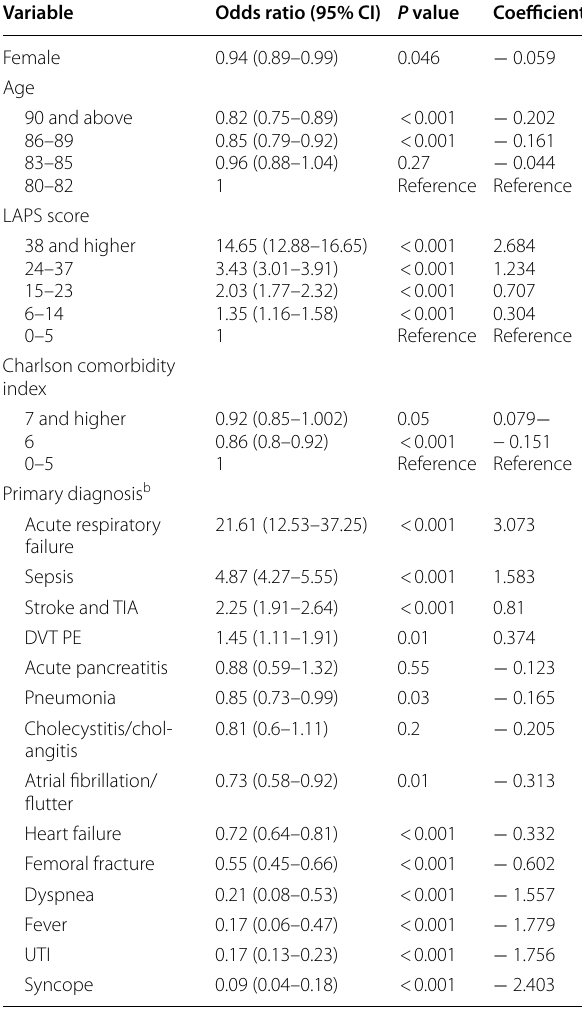
Figure 1 and Additional file 1: Table S5 show mortal- ity data of patients with the highest probability of ICU admissions in the Israeli and Australian cohorts, com- pared to the MIMIC-III cohort of BIDMC. After 6 and 12 months the survival rates were 62% and 58%, 74% and 66%, and 69% and 60% in USA, Australia, and Israel, respectively ( p value < 0.001 for both periods, log-rank test). At 24 months, the survival rates in the USA and Australia were 53%, while in Israel 48% ( p value 0.06).